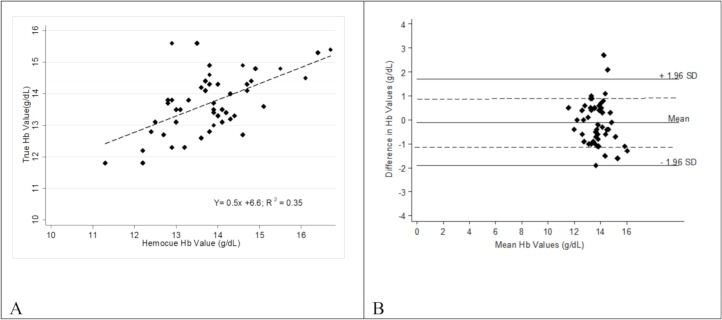
A. The correlation between the TrueHb and HemoCue® 201+ hemoglobin readings. B. A Bland Altman plot illustrating the bias (difference) between the TrueHb and HemoCue® 201+ hemoglobin readings, plotted against the average of the TrueHb and HemoCue® 201+ hemoglobin values.